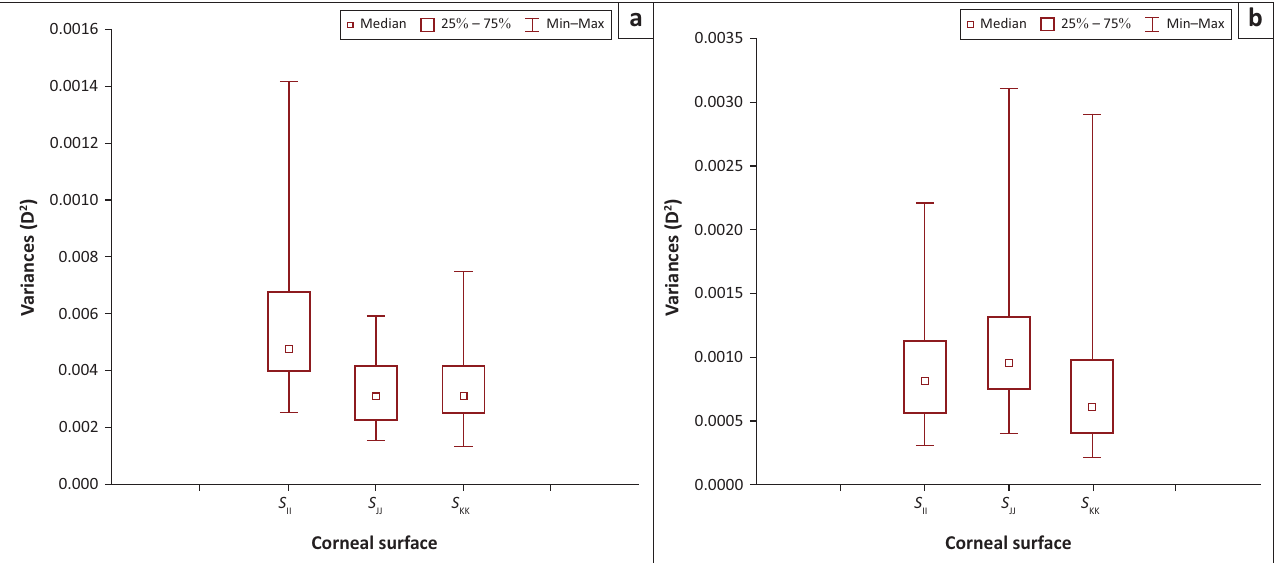
FIGURE 4: Box-and-whisker plots for stigmatic and antistigmatic variances of anterior and posterior central corneal power for 28 control eyes. Note the difference in scales on the y -axes when comparing with eyes with keratoconus in Figure 3. (a) Controls: Anterior corneal surface, (b) Controls: Posterior corneal